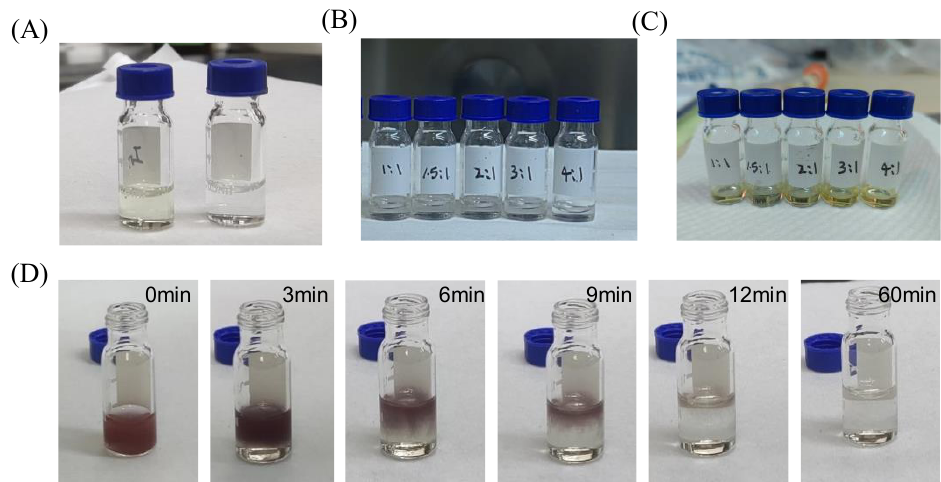
Figure 1. ( A ) Image of MAInICl 2 perovskite precursor solution ( left ) and the digestion solution ( right ). Images of the mixture of perovskite precursor solution and digestion solution in different proportions on ( B ) day 1 and ( C ) day 3. ( D ) Images of precipitation change process of perovskite precursor solution mixed with digestion solution.